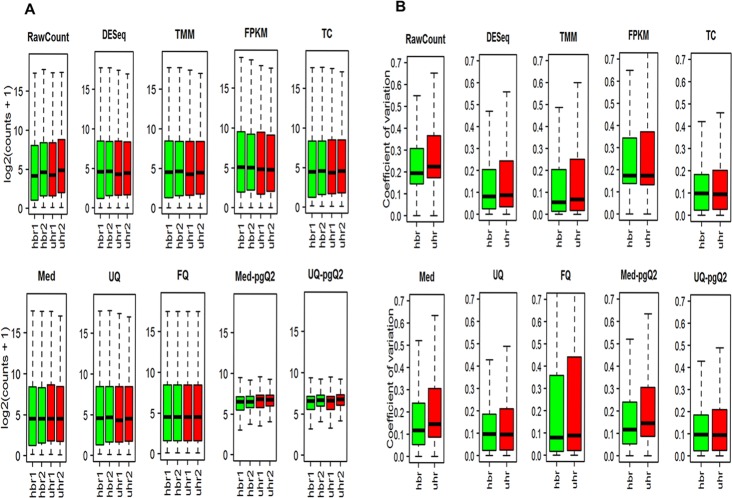
Comparison of nine normalization methods.(A) Illustrated are boxplots of log2 (counts+1) for MAQC data with two replicates in two conditions (uhr and hbr). The samples in hbr and uhr conditions are in green and red, respectively. Med-pgQ2 and UQ-pgQ2 are our proposed methods. (B) Illustrated are boxplots of the intra-condition coefficient of variation (uhr and hbr), respectively.